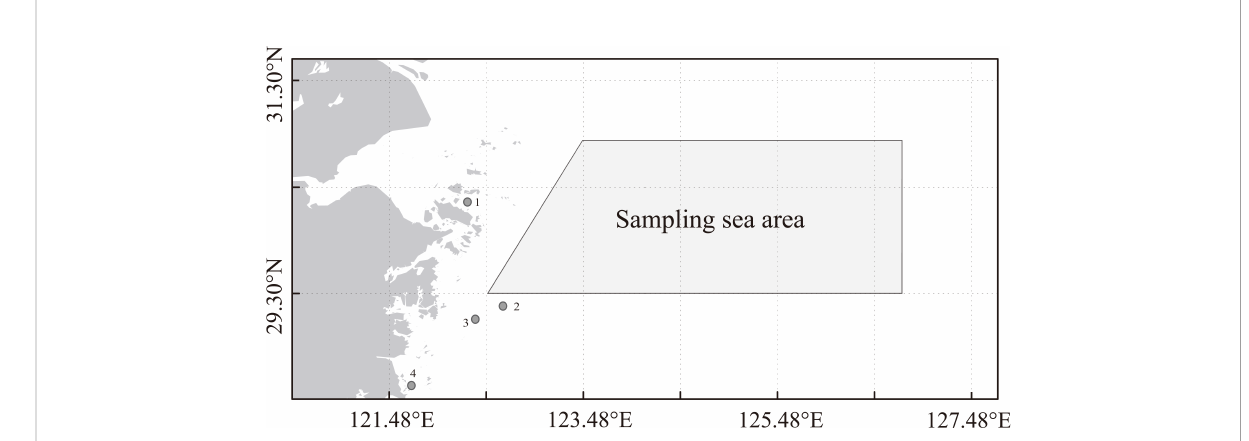
FIGURE 1 Map of sampling area of P. trituberculatus during 2015 and 2016 (Gao and Wang, 2021). [The points in the fi gure represent the enhancement and releasing areas centered on Zhoushan (1), Ningbo (2), Taizhou (3), and Wenzhou